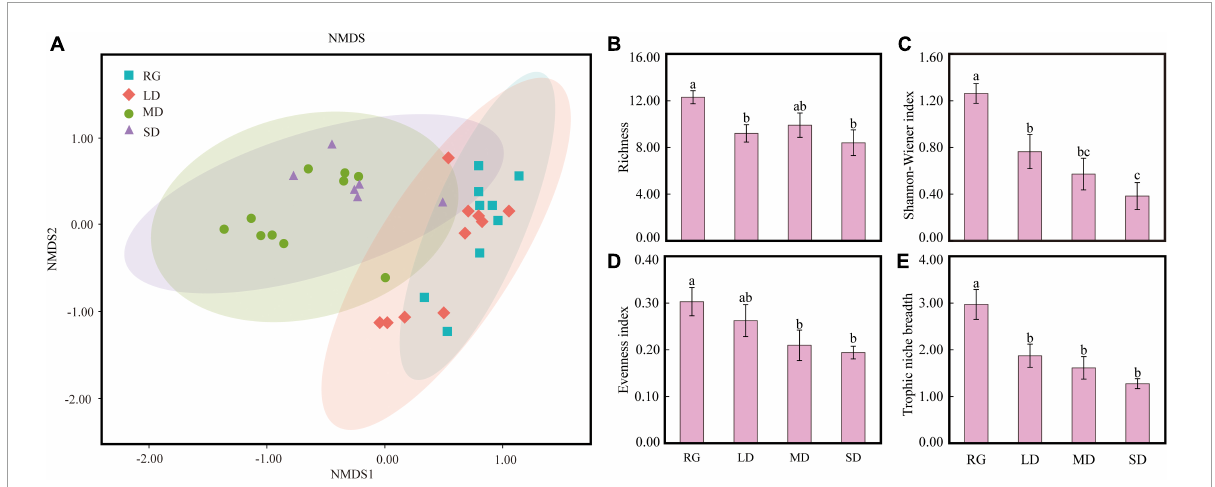
FIGURE7 NMDS analysis of food structure of plateau zokors (A) , food richness (B) , Shannon-Wiener index (C) , evenness index (D) , and food niche width (E) . LD, lightly degraded grassland; MD, moderately degraded grassland; SD, severely degraded grassland; RG, reseeded grassland. Different letters indicate significant differences between groups ( P <